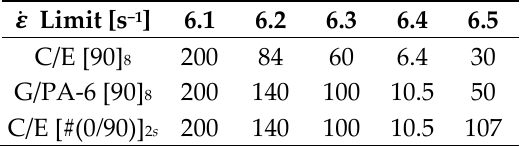
Table 1. Limits on strain rate. The numbers correspond to the subsections of Section